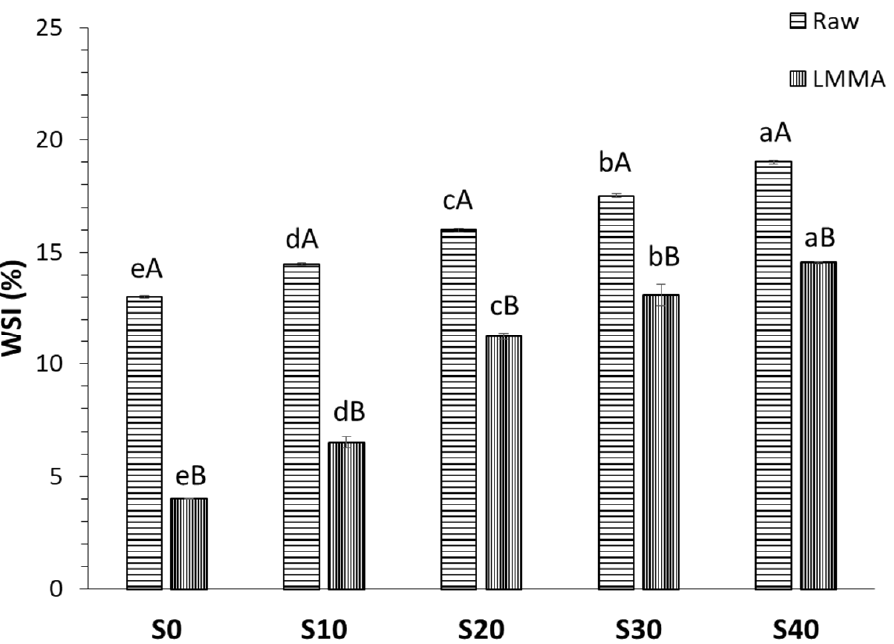
Figure 1. Effect of mycelium addition on water solubility index. All the values are mean ± SD ( n = 3).